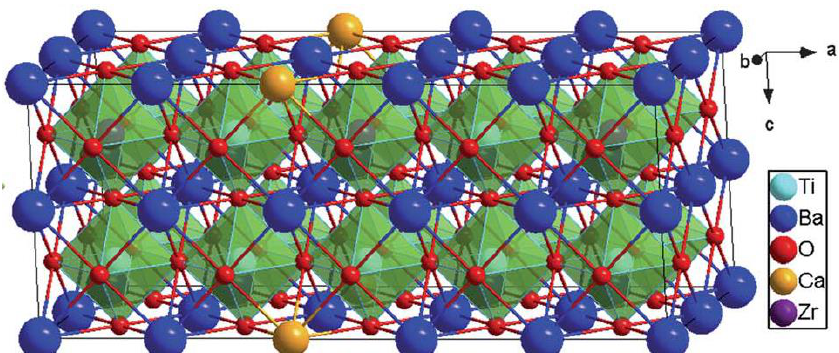
Figure 3. Cubic perovskite structure and arrangements of atoms in a B 0.95 C 0.05 Z 0.15 T 0.85 O 3 supercell with 5 × 2 × 2 dimension. Reprinted with permission from [54]. Copyright 2012 Royal Society of Chemistry.